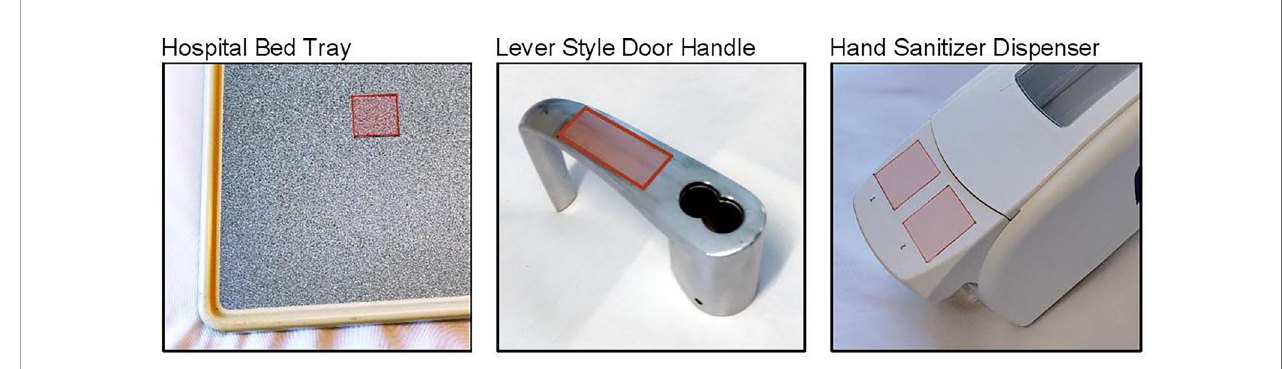
FIGURE 1 | Surfaces tested for human norovirus swab recovery. Red boxes indicate 3 cm 2 areas that were inoculated and